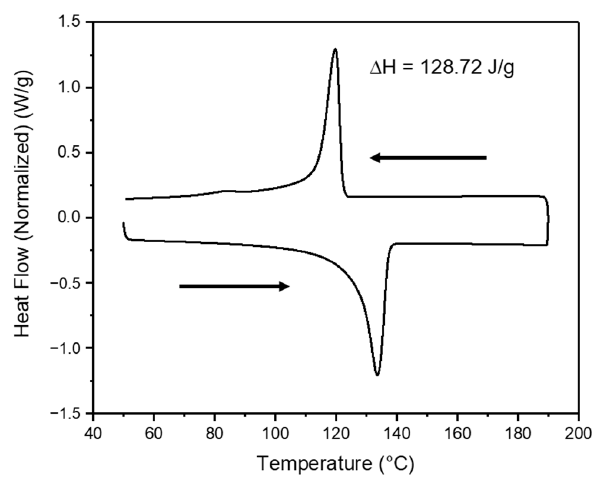
Figure 1. Differential Scanning Calorimetry heat flow curve of UHMWPE film at a heating rate 4.25 °C/min, dwell time 1 h, and cool down at 3.5 °C/min rate.